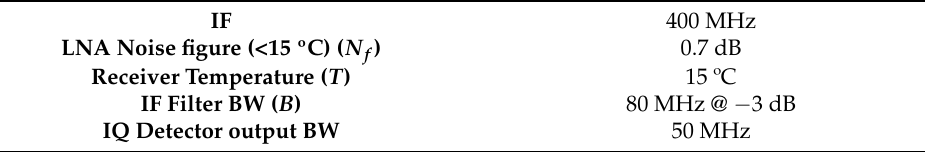
Table 4. Receiver operating